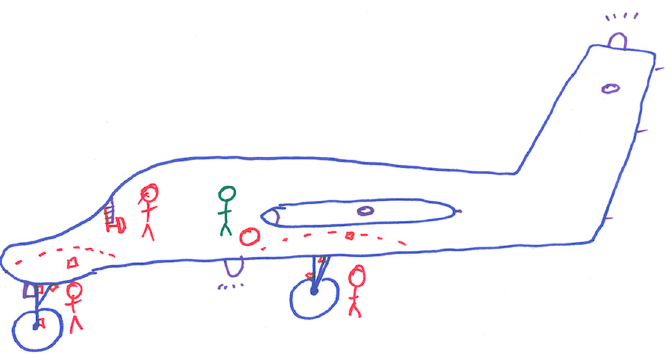
Figure 1. Example pen-paper scenario drawing of a re-rigging landing gear task created by a participant in the study. The green figure (middle-right) depicts the avionics technician and the